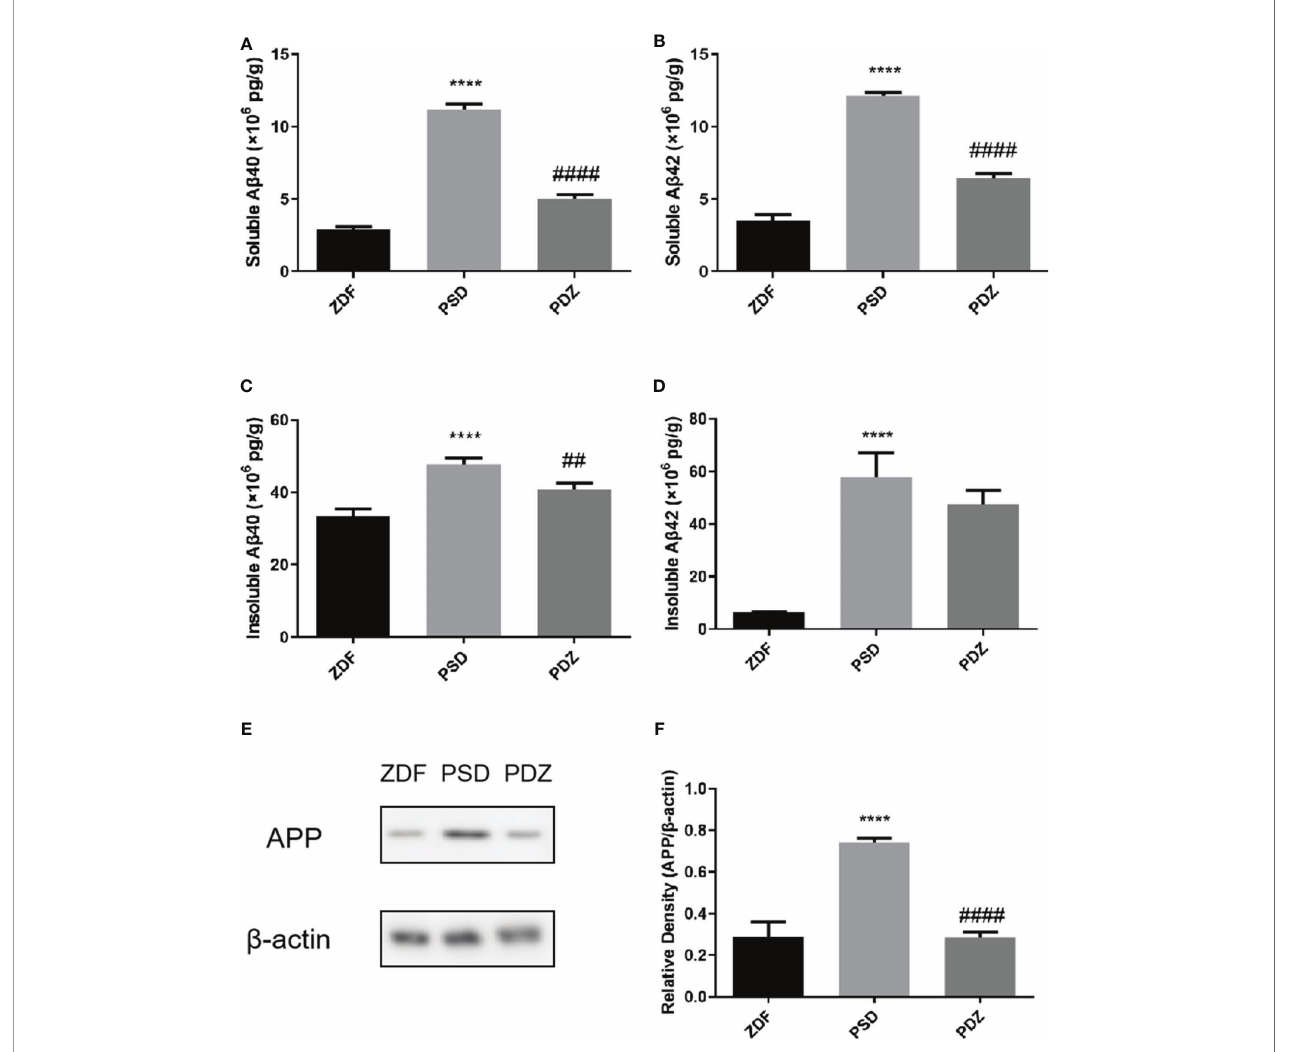
FIGURE 6 | Effect of ZBPYR on generation and deposition of b -amyloid in the medial prefrontal cortex (mPFC) of ZDF rats. Levels of soluble and insoluble A b 40 and A b 42 in the mPFC of each group were measured using enzyme-linked immunosorbent assay (A – D) . Protein expression of APP in the mPFC of each group were detected by western blotting (E, F) . Bars represent the mean ± SEM. **** P < 0.0001, PSD group vs. ZDF group; ## P < 0.01, #### P < 0.0001, PDZ group vs. PSD